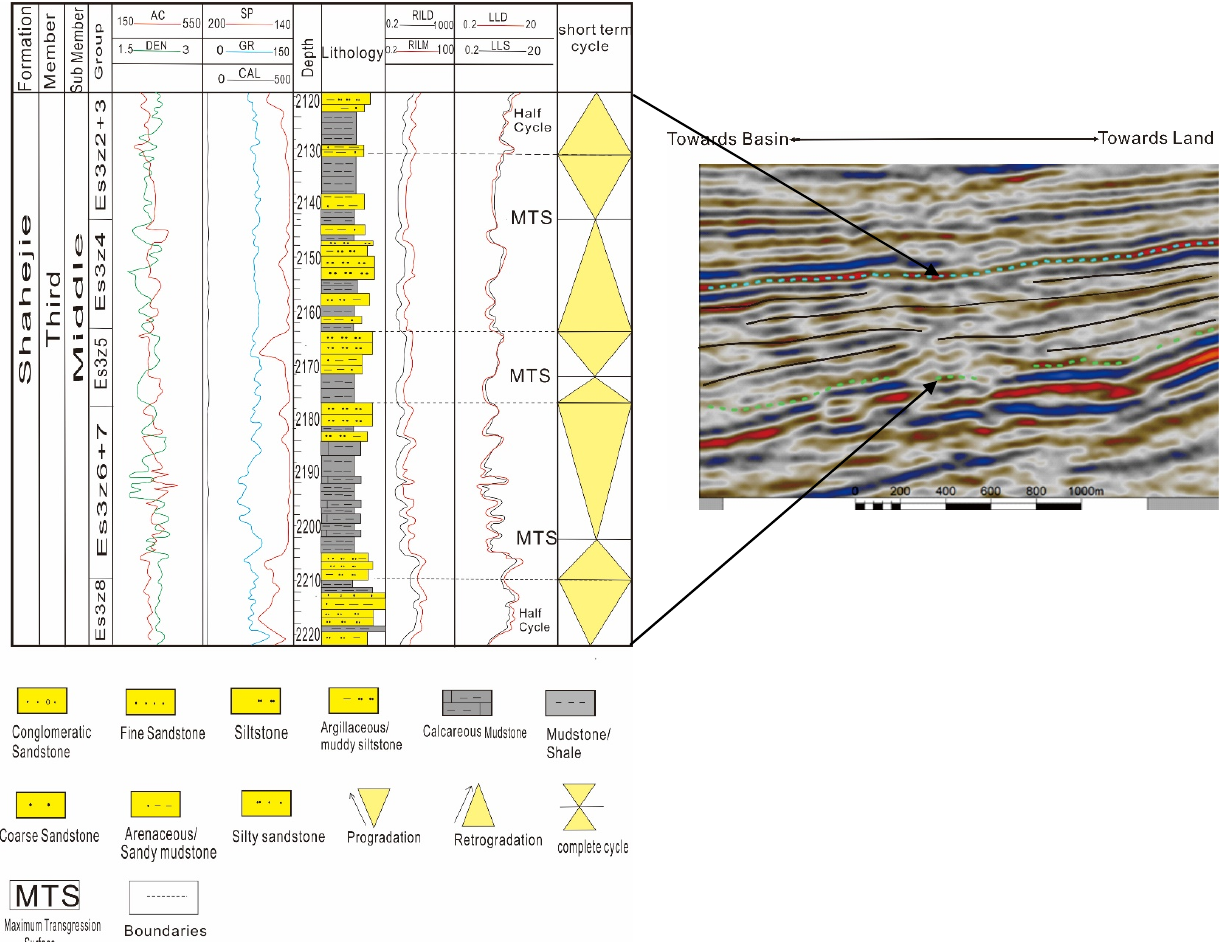
Figure 2. Single well interpretation and representative seismic signals (Well k45) using multiple logs in the middle sub-member of the Shahejie Formation (Es3z), including five groups of sandstones, namely Es3z2+3, Es3z4, Es3z5+6, Es3z7, and Es3z8 in third order sequence. (Top of Es3z2+3 and the bottom unit of Es3z+8 is shown by arrows on seismic). For each group of sandstones, system tracts are recognized by interpreting wireline-log motifs with lithological successions and groupings by (1) sharp lithological contacts (e.g., truncation of clean sandstone with the underlying mudstone or shale), (2) changes in logging curves. Strong negative amplitude (red) marked as sandstone, positive amplitude (grayish) marked as mudstone, area of weak negative amplitude (brownish) siltstone or argillaceous siltstone